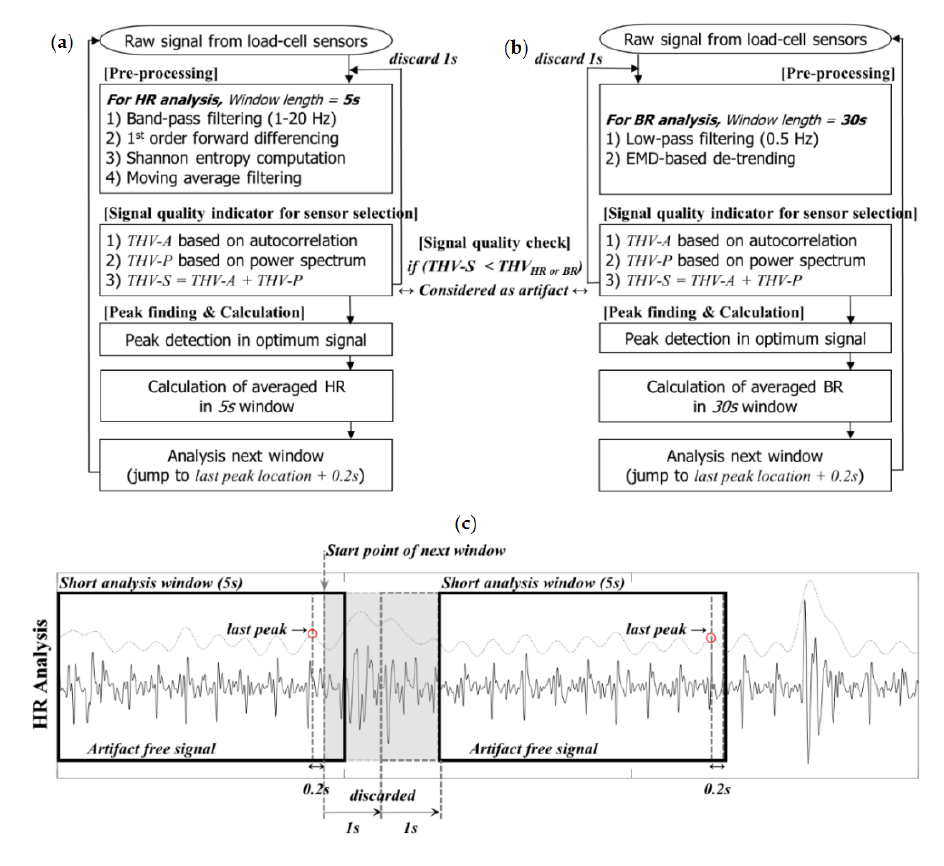
Figure 4. Flowchart of the proposed algorithms for automatic ( a ) HR and ( b ) BR analysis, (c) Partial example of HR analysis.